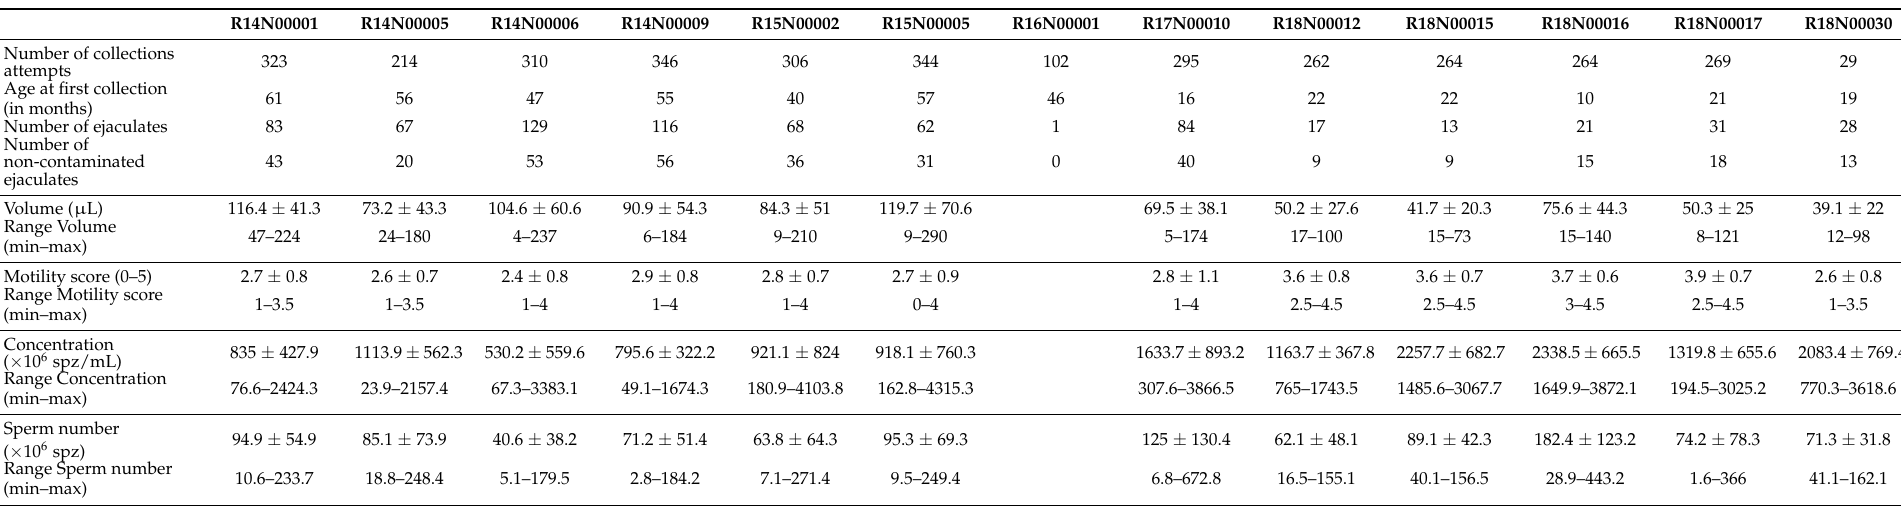
Table A2. Arabian bustard individual sperm collection results and semen characteristics. Only ejaculates that were not contaminated with urates, feces, or red blood cells were considered for overall semen